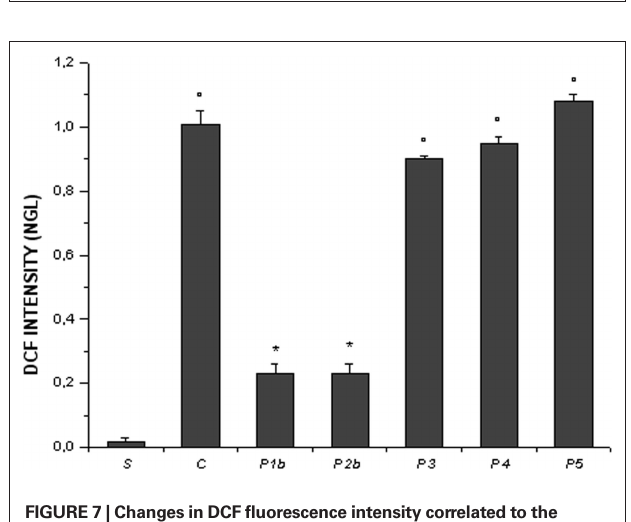
FiGuRE 7 | Changes in DCF fluorescence intensity correlated to the intracellular reactive oxygen species (ROS) levels at the end of reperfusion (ER) in the experimental groups, as reported in Figure 2 legend. ° p < 0.01 vs. sham-operated group, * p < 0.01 vs. C